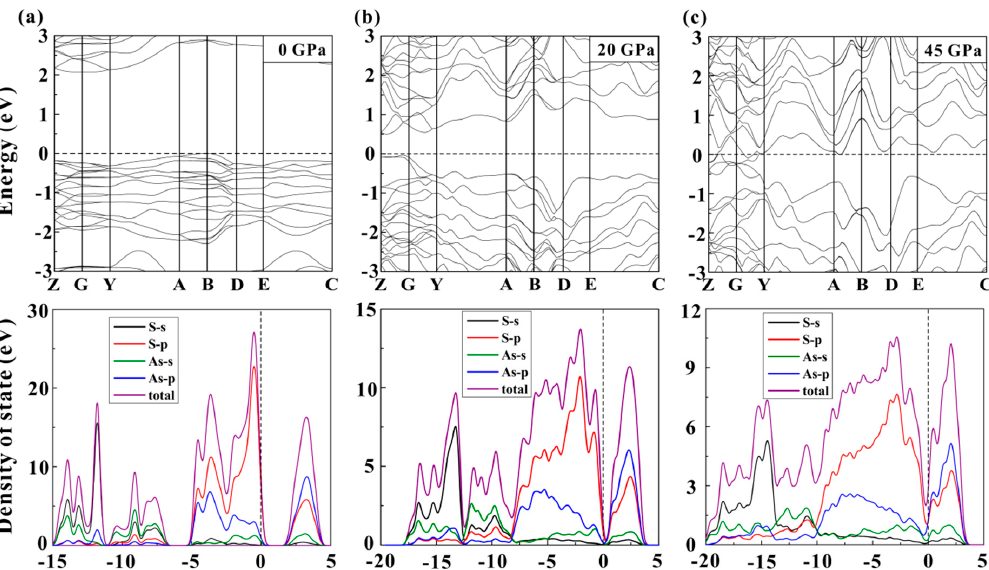
Figure 9. The selected band structure and the corresponding total and partial density for orpiment at different pressure. ( a ) and ( b ) The bandgap energy at 0 and 20 GPa are 2.07 and 0.51 eV, respectively. ( c ) The bandgap has already closed at the pressure of 45 GPa. The bandgap of orpiment narrows with increasing pressure.